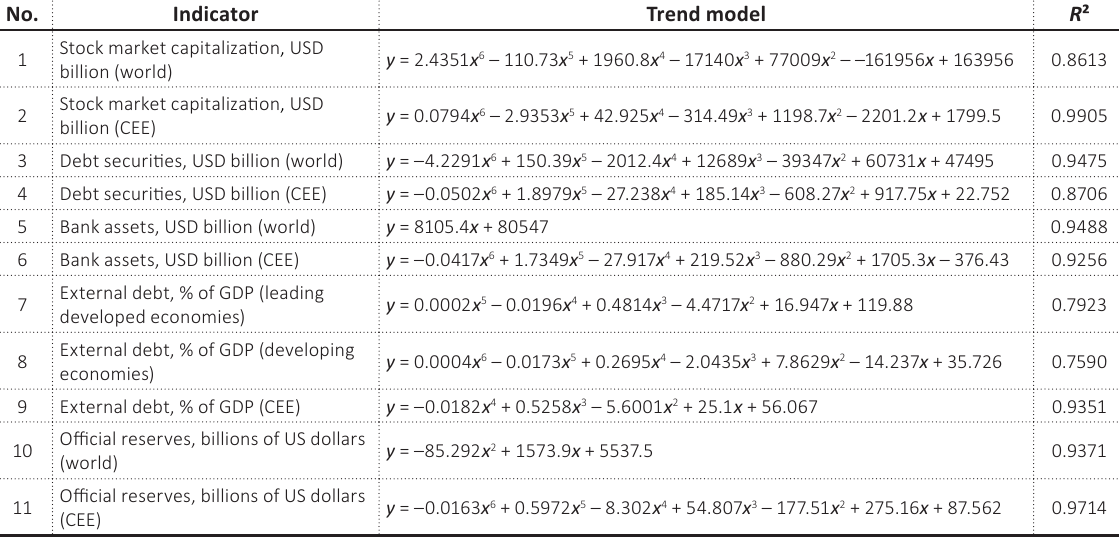
Table 4. Trend models of global and regional financial indicators